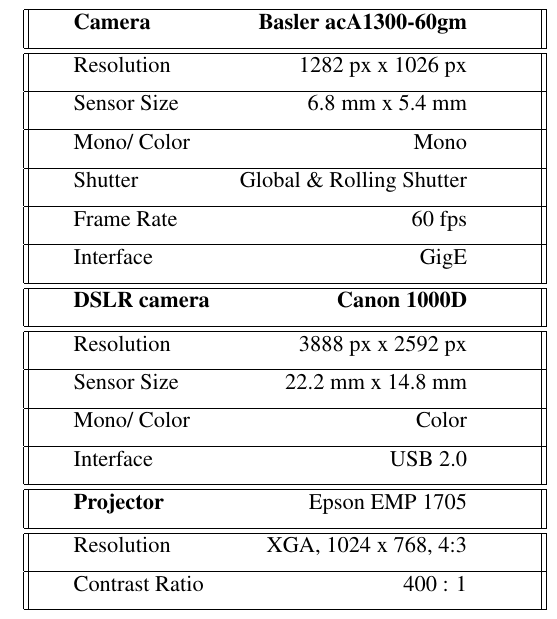
Table 1. Main specifications of the photogrammetric system images of studied objects. So the calibration of the photogram- metric system was performed for all three cameras using one cal- ibration test field. This technique provides accurate texture map- ping and accurate 3D coordinates measuring of the textured 3D model.